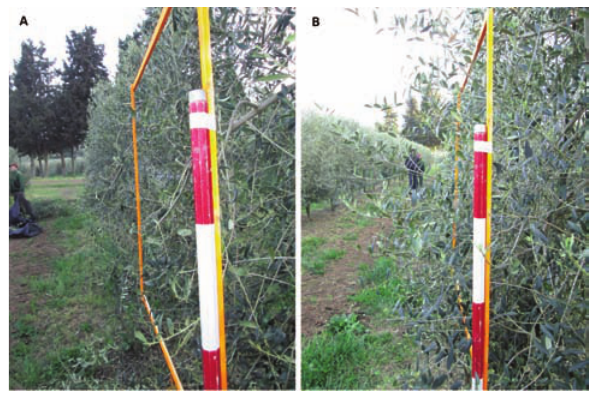
Fig. 1 - Sampling units after the pruning in the Casale San Giorgio farm (2015): A) Air flow Off; B) Air flow